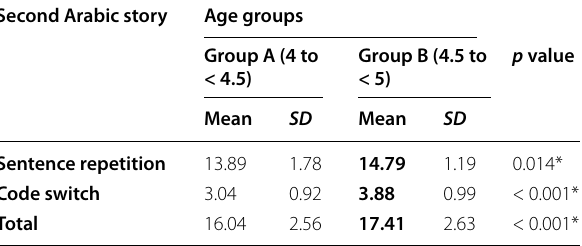
Table 10 Comparison between the two age groups regarding the scores of second Arabic Narration Test (the boy and his grandpa)